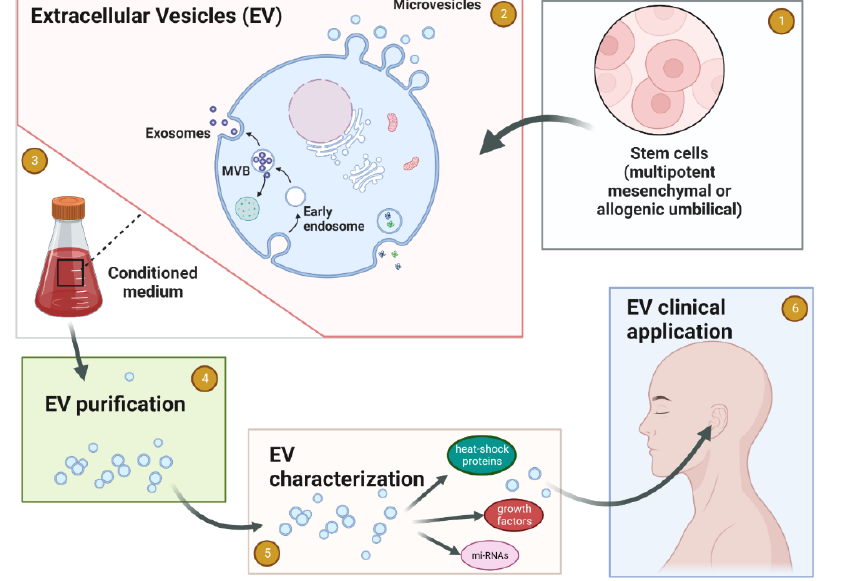
Figure 1. Schematic flow of EV production for medicinal use in Neurotology. (1) Establishing the cell source for EV. (2) Cells release the EV 3 to the tissue culture media. (3) Collection of the conditioned medium. (4) EVs purification. (5) EVs characterization. (6) Clinical application of purified and characterized EVs for the inner ear conditions. Created with